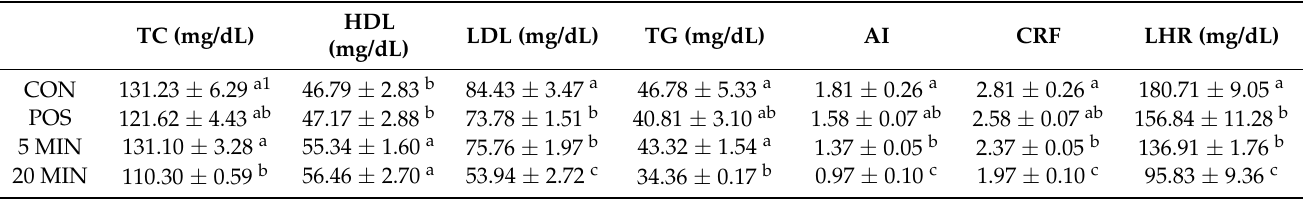
Table 7. Effects of basil essential oil and linalool inhalation on lipid metabolism in chronically stressed rats. CON: chronic stress-exposed control group; POS: linalool (positive control) inhalation by chronic stress-exposed rats; 5 MIN: BEO inhalation for 5 min by chronic stress-exposed rats; 20 MIN: BEO inhalation for 20 min by chronic stress-exposed rats.